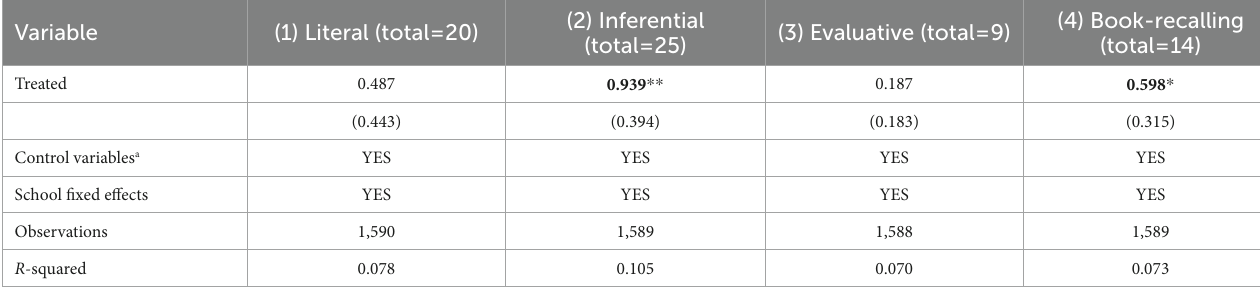
TABLE 3 Effects of the reading instruction program on students’ reading skill development for different comprehension item types (robust standard errors in parentheses). Variable